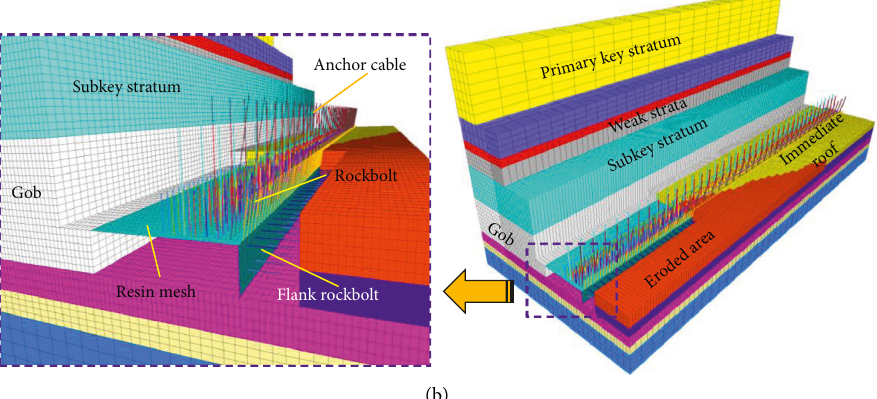
Figure 14: Numerical models for two kinds of support designs. (a) Initial support design. (b) Improved support design.